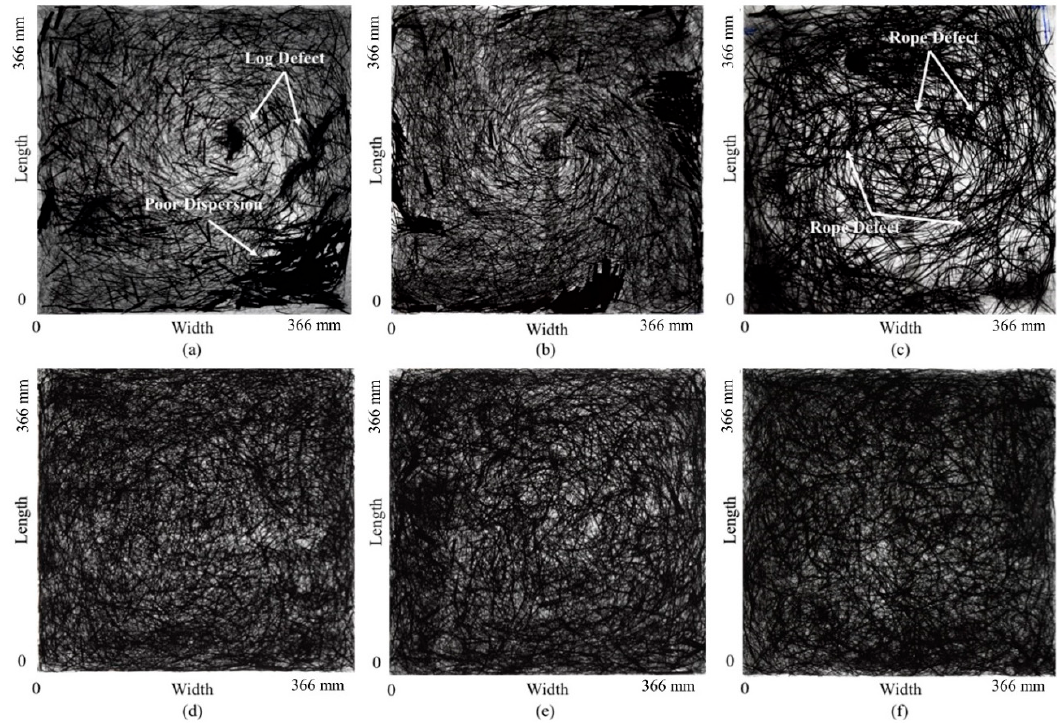
Figure 1. Back light scatter images of nonwoven wet laid carbon fiber (WL-CF) mats prepares using: ( a ) Method 1 at 10 min fiber dispersion; ( b ) Method 1 at 20 min fiber dispersion; ( c ) Method 1 at 30 min fiber dispersion; ( d ) Method 2 at 10 min fiber dispersion; ( e ) Method 2 at 20 min fiber dispersion; ( f ) Method 2 at 30 min fiber dispersion. All mats used in this study are prepared with 20 min fiber dispersion. Adopted from [5] .